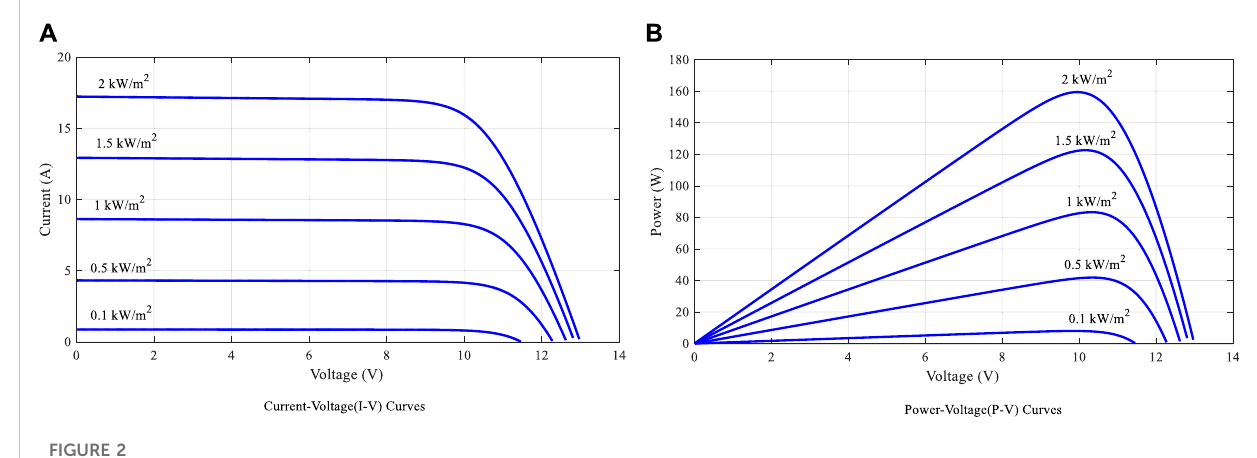
FIGURE 2 Characteristic curves for different irradiance levels. (A) I-V Curves, (B) P-V